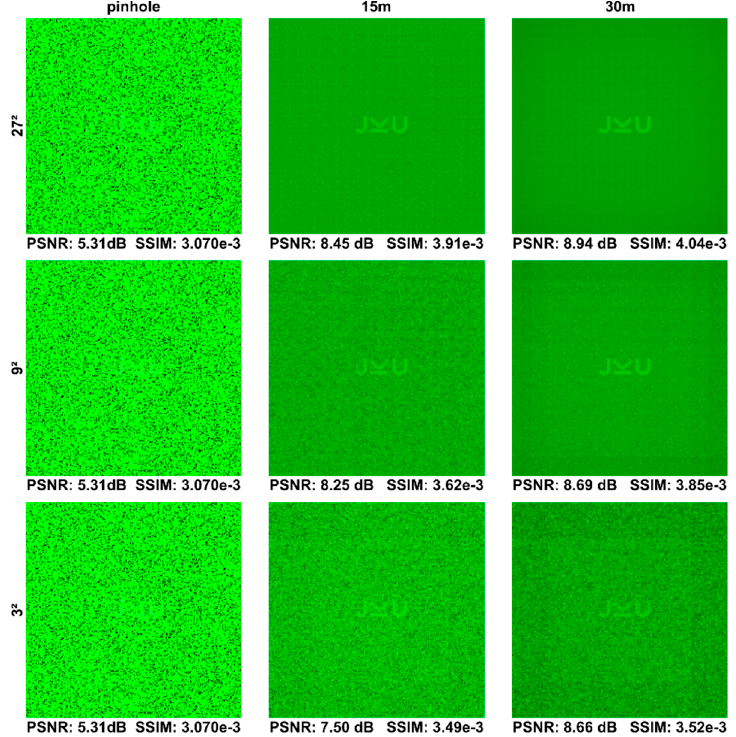
Figure A4. AOS simulation of various synthetic aperture diameters (pinhole = single drone recording, 15 m, and 30 m) and directional sampling resolutions within the selected synthetic aperture (3 2 , 9 2 , and 27 2 perspectives). The occlusion density is 50%. Projected occlusion voxels are green. The numbers indicate the structural similarity index (Quaternion SSIM [38]) and the PSNR with respect to the ground truth.